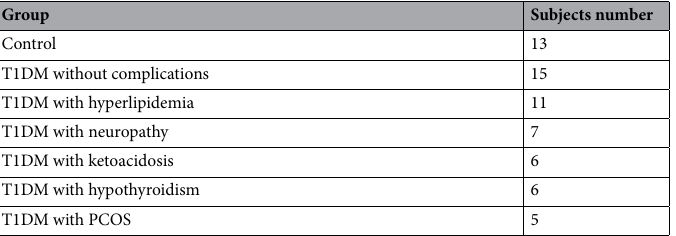
Table 1. Groups of the studied population. Total number of subjects in each group has been presented including control group, T1DM without complications, T1DM with hyperlipidemia, neuropathy, ketoacidosis, hypothyroidism and PCOS. T1DM Type I Diabetes Mellitus, PCOS Polycystic Ovary